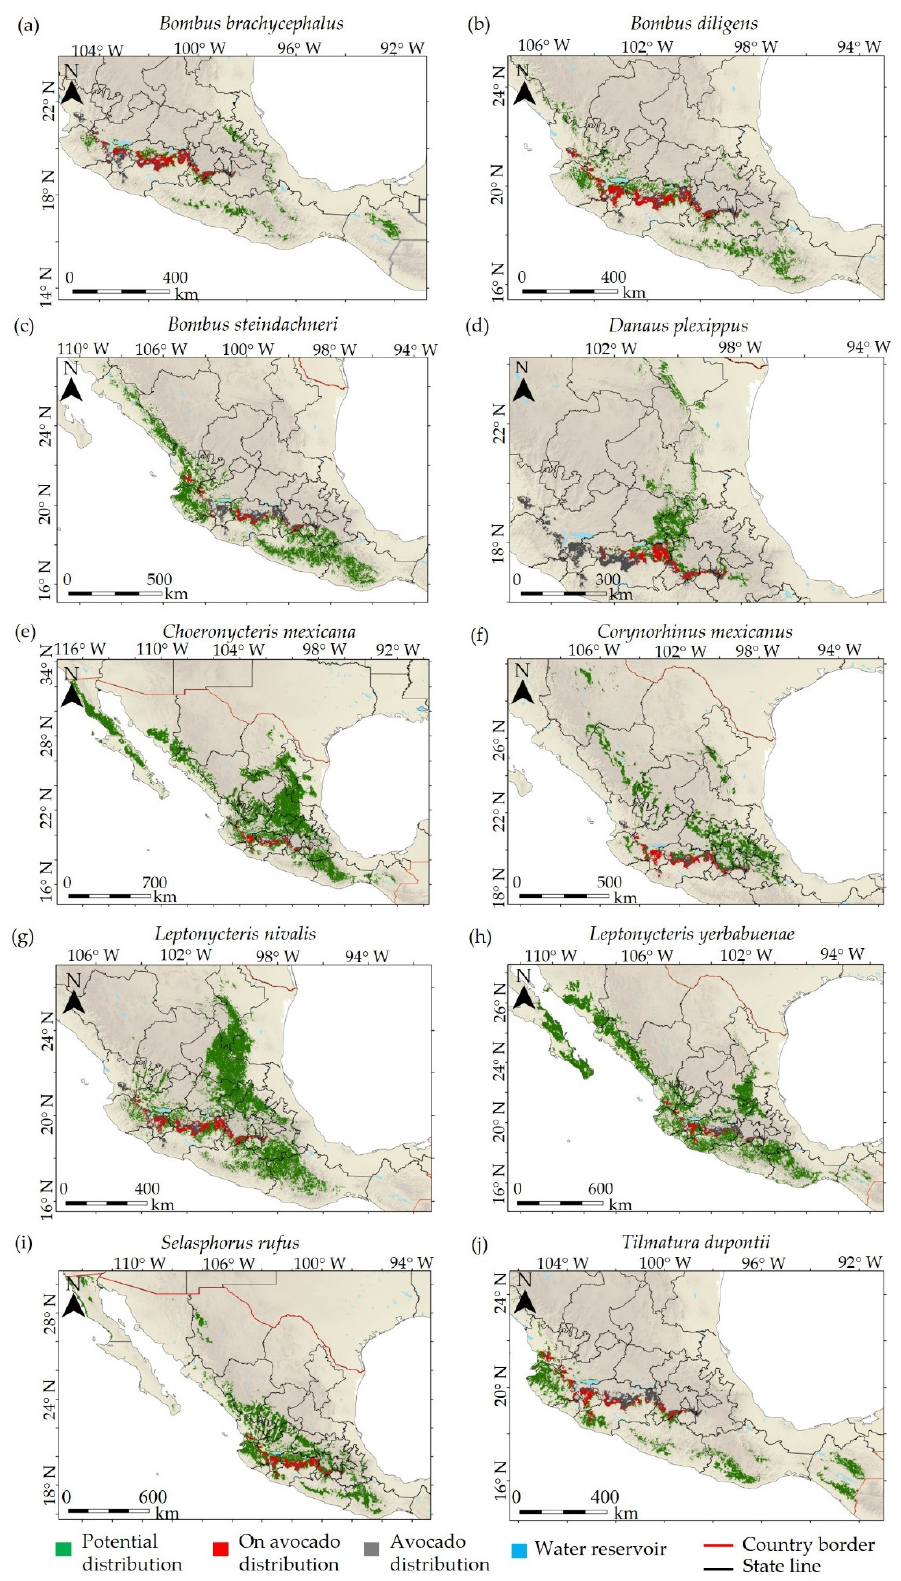
Figure 3. Potential distribution of ten threatened pollinator species at risk from the expansion of Hass avocado monoculture in Mexico. Species key: ( a ) Bombus brachycephalus , ( b ) Bombus diligens , ( c ) Bombus steindachneri , ( d ) Danaus plexippus , ( e ) Choeronycteris mexicana , ( f ) Corynorhinus mexicanus , ( g ) Leptonycteris nivalis , ( h ) Leptonycteris yerbabuenae , ( i ) Selasphorus rufus , ( j ) Tilmatura dupontii